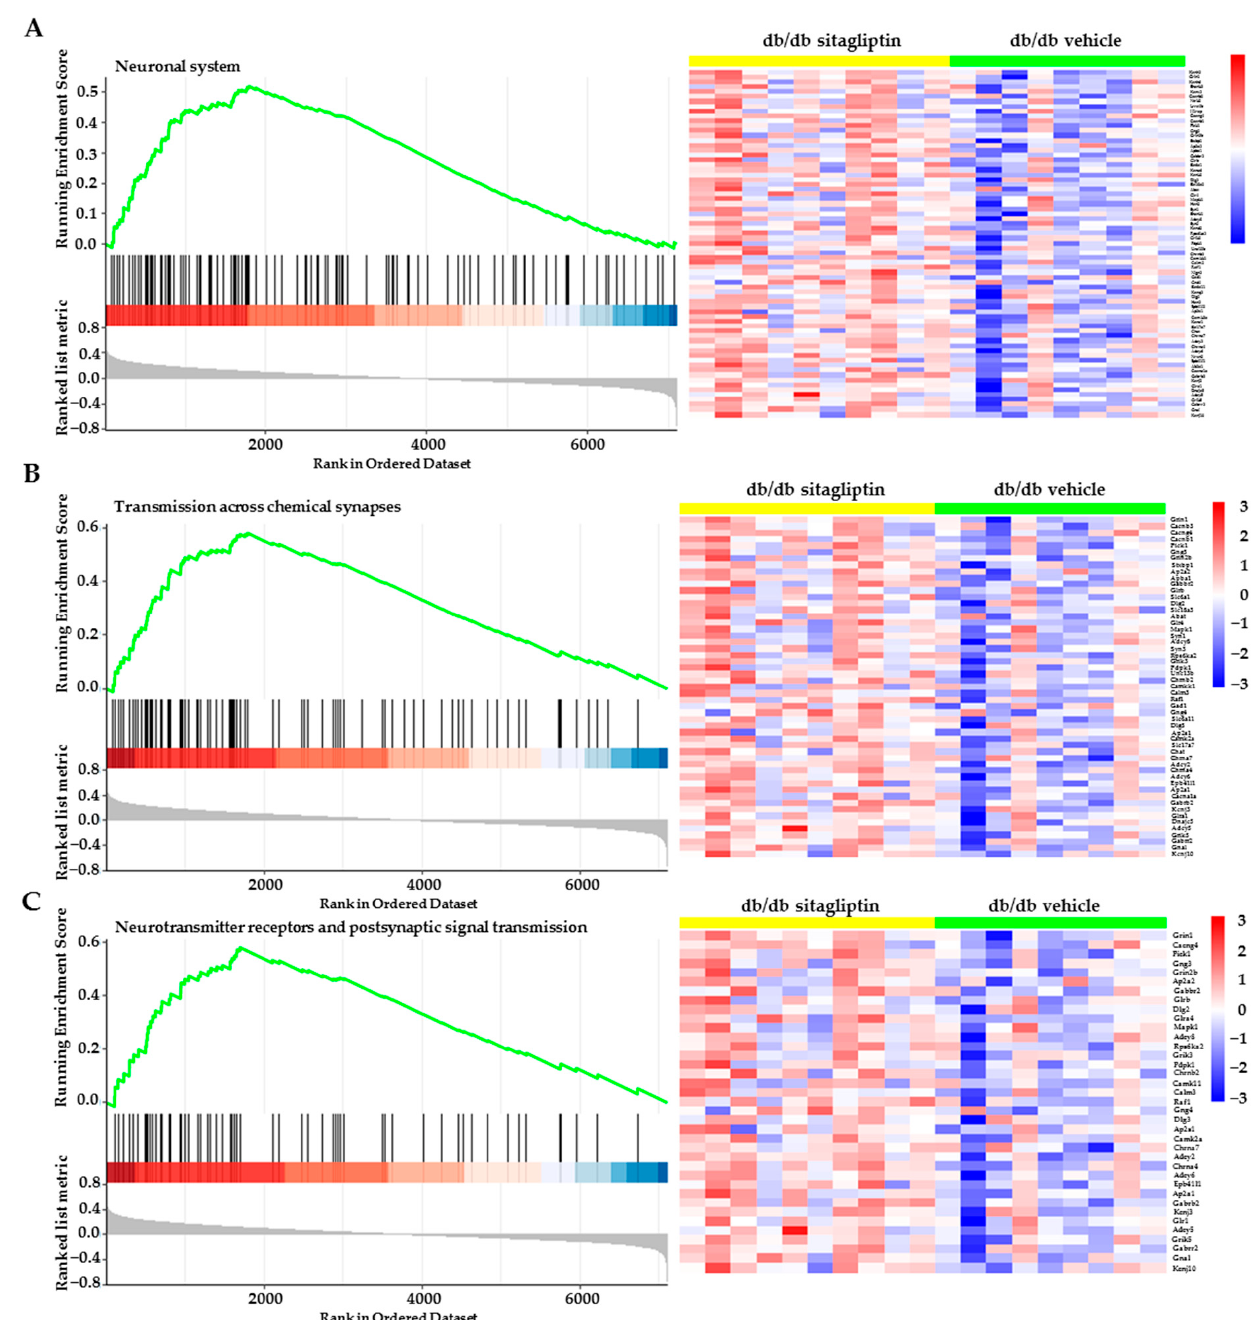
Figure 5. Gene set enrichment analysis (GSEA). ( A – C ) Heatmaps of the most enriched neurotransmission-related pathways between vehicle-treated db/db mice and sitagliptin-treated db/db mice. Reanalysis of the GO study, not only using the BP category but also incorporating the Molecular Function (MF) and Cellular Component (CC) categories and limiting the search to neuronal terms, confirmed the Reactome results (Figure 6A–C). An enrichment map of the most differentiated gene sets associated with synaptic transmission (BP cate- gory) can also be observed for the sitagliptin vs. vehicle comparison in Figure 6D.